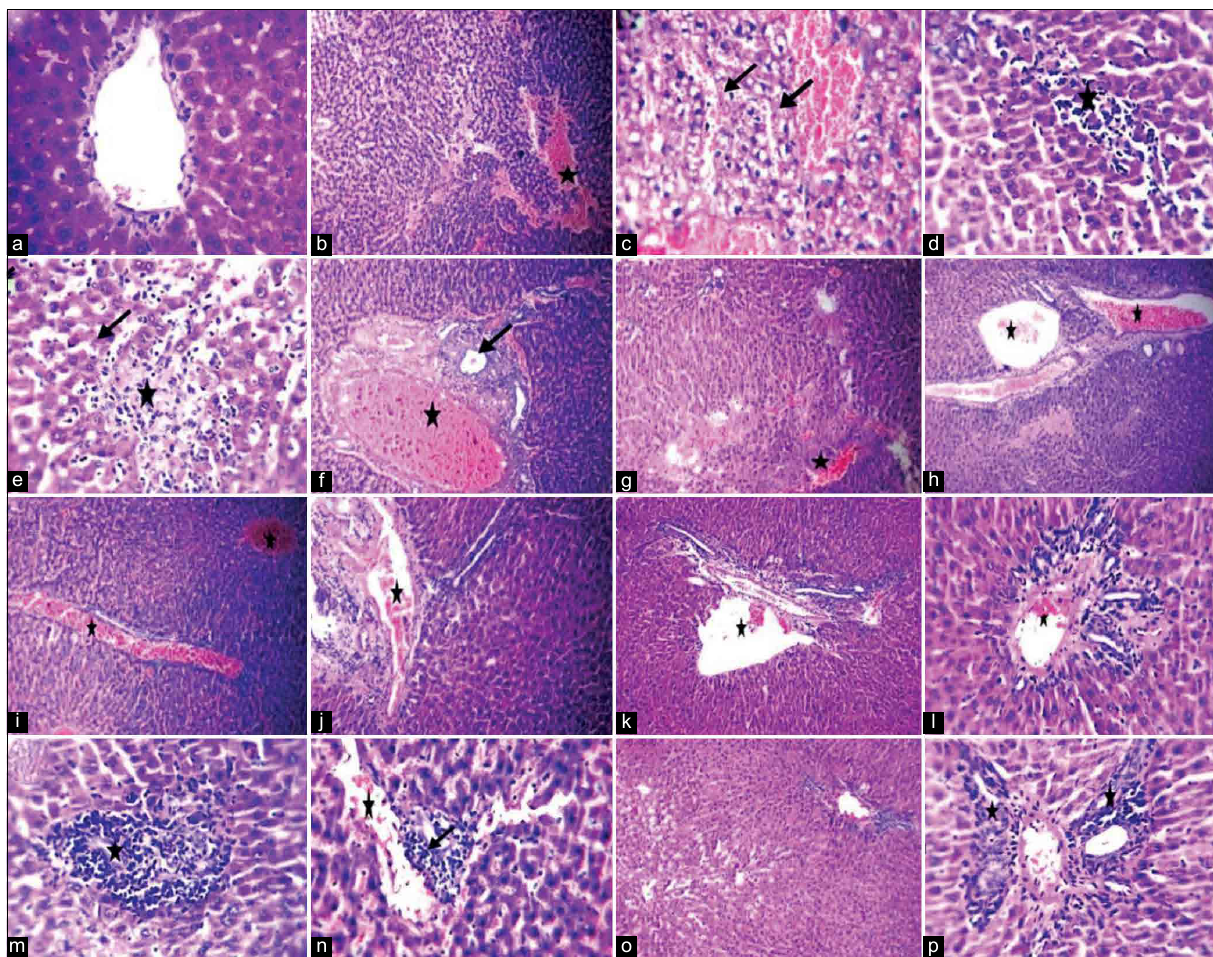
Figure-11: Histopathological examination of liver in different Toxocara vitulorum -rat models. Liver slides of healthy rats showing: (a, 20×) Apparently normal hepatocytes and central vein. (b, 10×) Liver sections of untreated T. vitulorum -rat model showing: Congestion of sinusoids and a wide area of hemorrhage (asterisk). (c, 20×) congestion and dilatation of sinusoids with micro and macrovesicular steatosis (arrows). (d and e, ×20) a focal area of hepatic necrosis (arrow) with leukocytic infiltration (asterisk). (f, 10×) congestion of sinusoids and portal veins (asterisk) and biliary hyperplasia (arrow). (g, 10×) Liver sections of rats at 4 th week following albendazole therapy showing: Congestion of sinusoids and hemorrhage (asterisk) with hepatic necrosis. (h, 10×) congestion of portal veins (asterisk). (i, 10×) congestion of sinusoids, central and portal veins (asterisks). (j, 10×) congestion of portal veins with fibroplasia (asterisk). (k, 10×; l, 20×) Liver sections of rats at 4 th week after albendazole with BMMSCs therapy showing: Slight congestion (asterisks) and portal area infiltrates with leukocytic without steatosis. (m, 20×) leukocytic infiltration (asterisk) in injured liver. (n, 10×) slight congestion of sinusoids and portal veins (asterisk) with leukocytic infiltrates (arrow). (o, 10×) nearly normal hepatic cells with leukocytic infiltrates of the portal vein. (p, 20×) dilatation and slight congestion of portal veins and leukocytic infiltration were observed in portal area. BMMSCs=Bone marrow mesenchymal stem